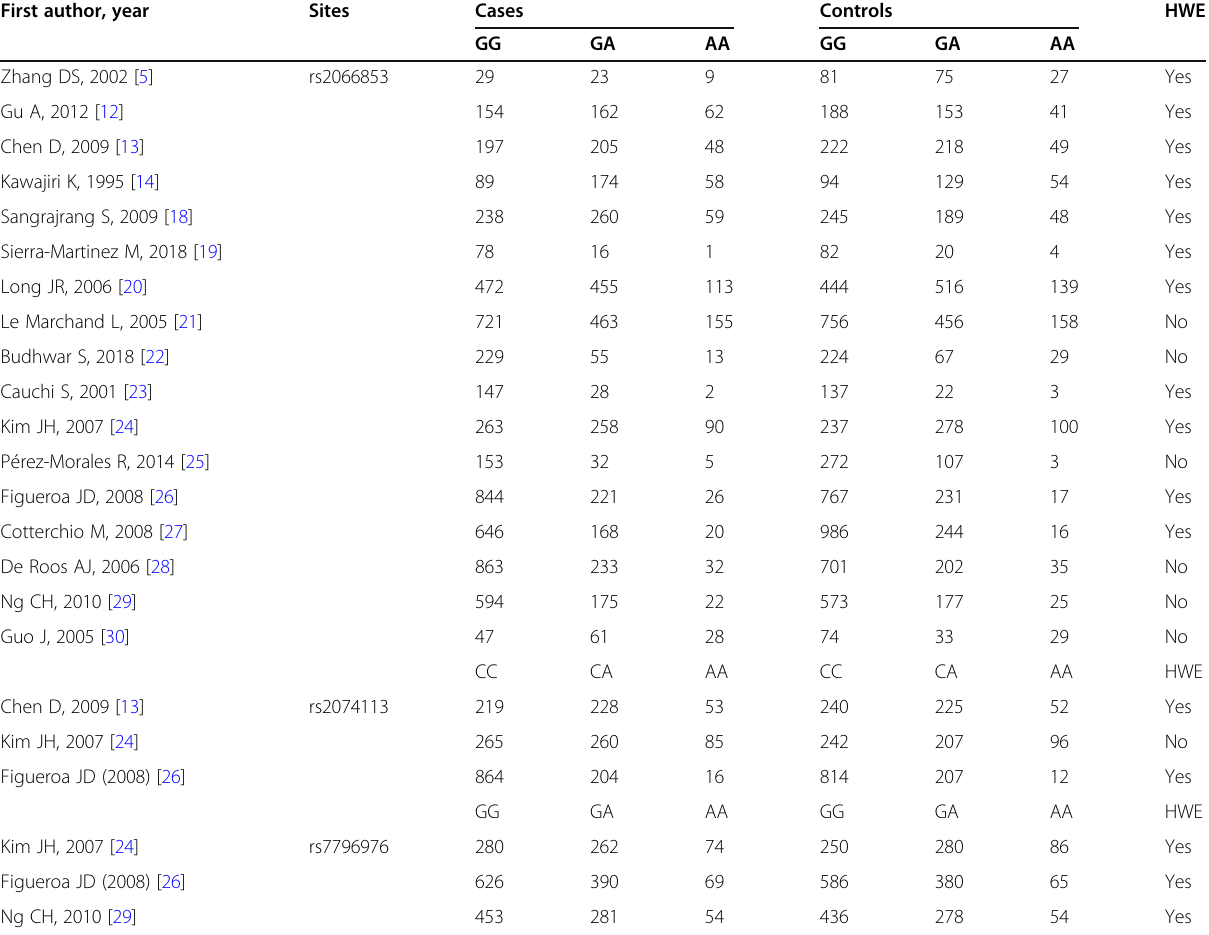
Table 2 Genotype and allele distributions of AhR polymorphisms in cases and